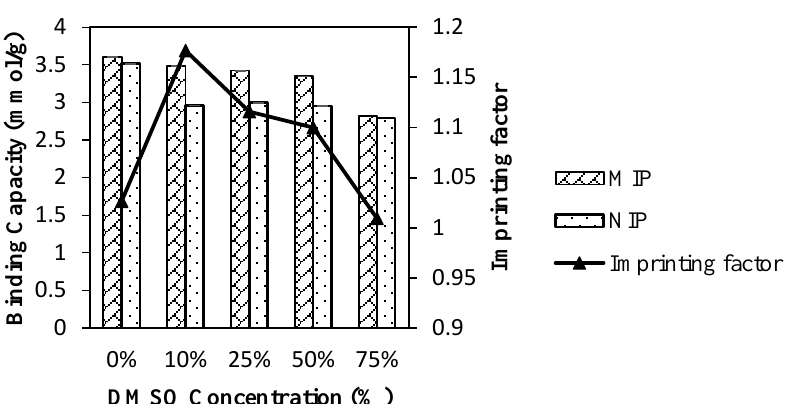
Figure 4. Adsorbed amounts of Atr by MIP and NIP for different porogenic solvent